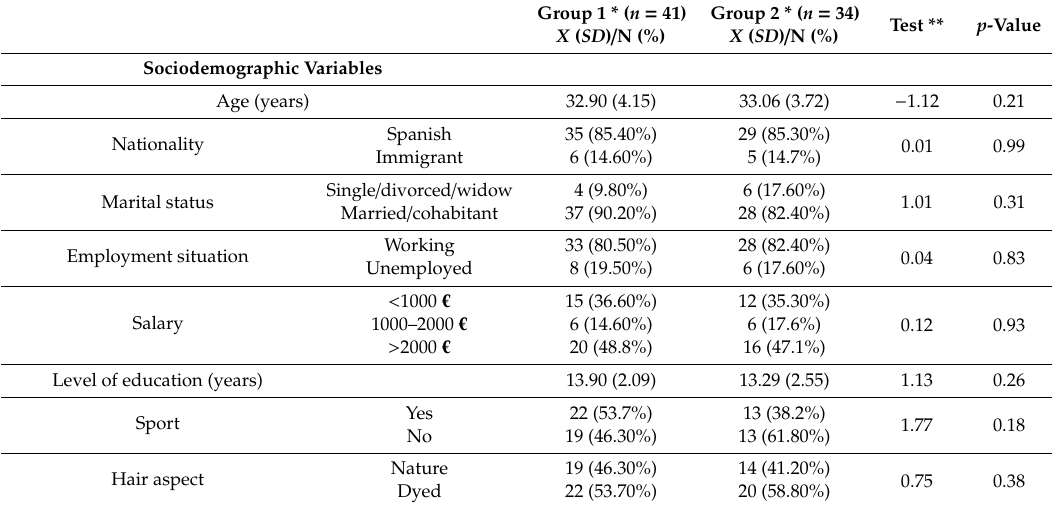
Table 1. Di ff erences in sociodemographic, obstetrics, and hair cortisol levels between Group 1 (final sample) and Group 2 (participants not attending the neurodevelopment assessment